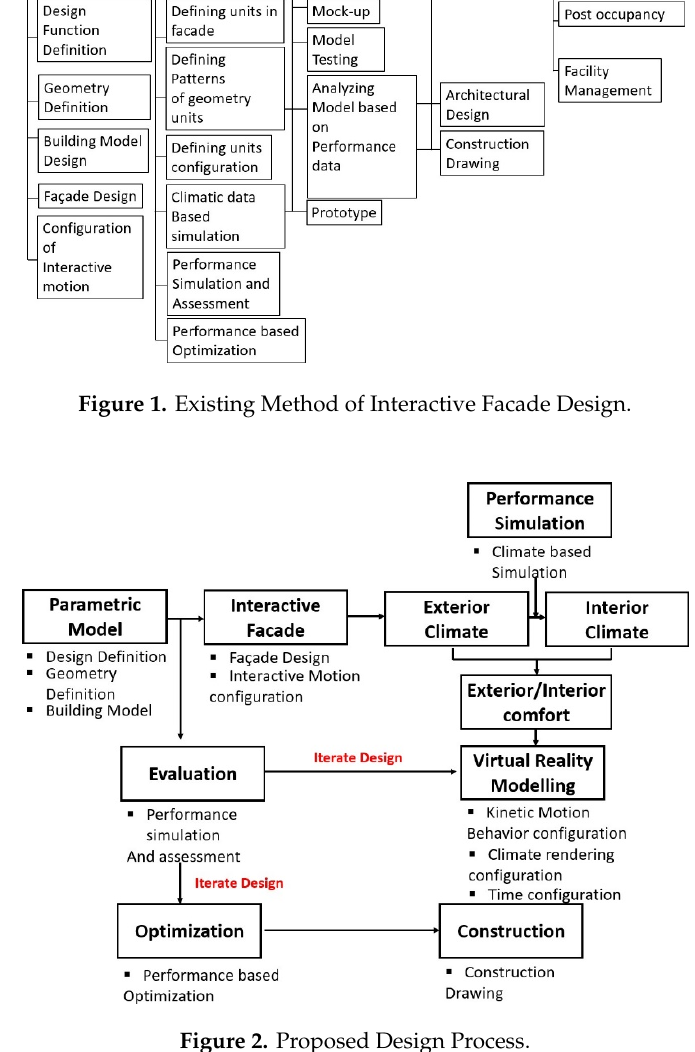
Figure 1. Existing Method of Interactive Facade Design.